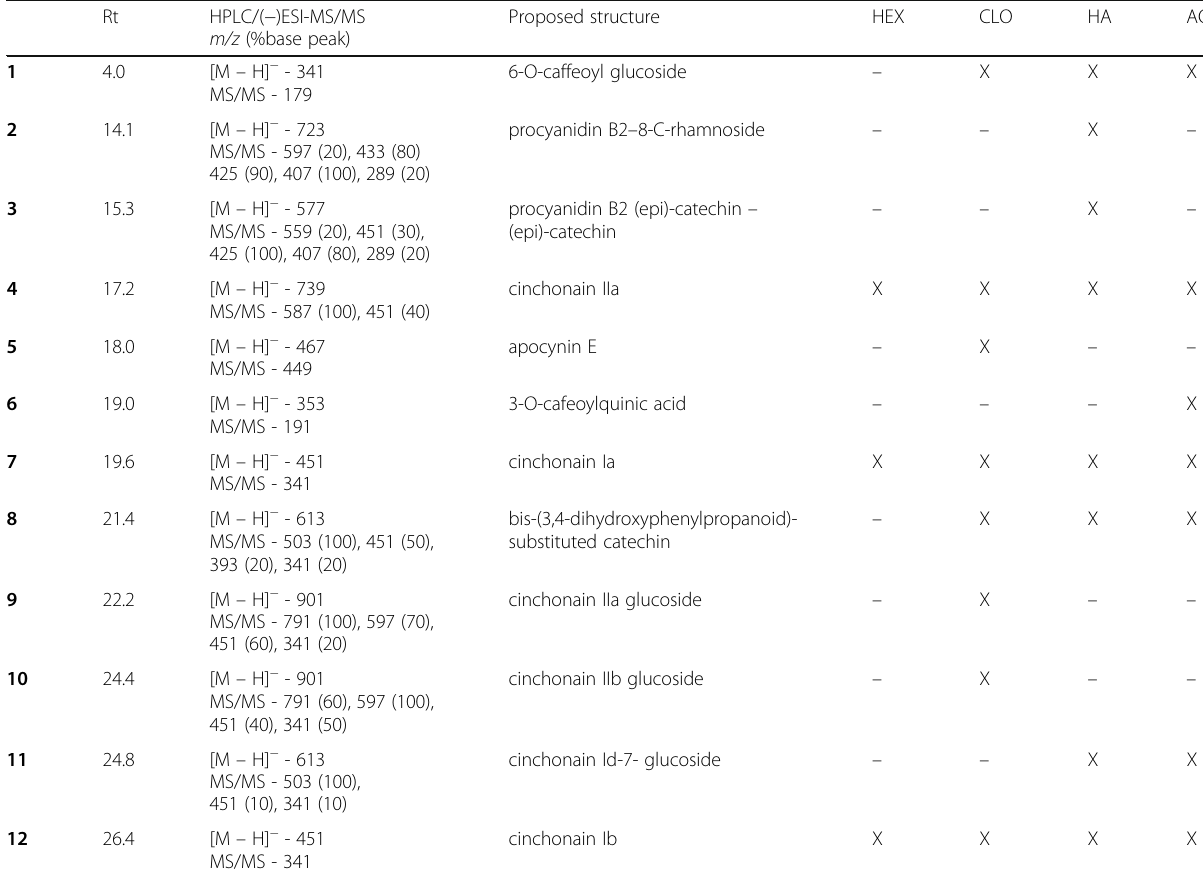
Table 1 Summary of the MS data obtained in the analysis of the hexane (HEX), chloroform (CLO), hydroalcoholic (HA) and aqueous (AQ) extracts from barks of Trichilia catigua through